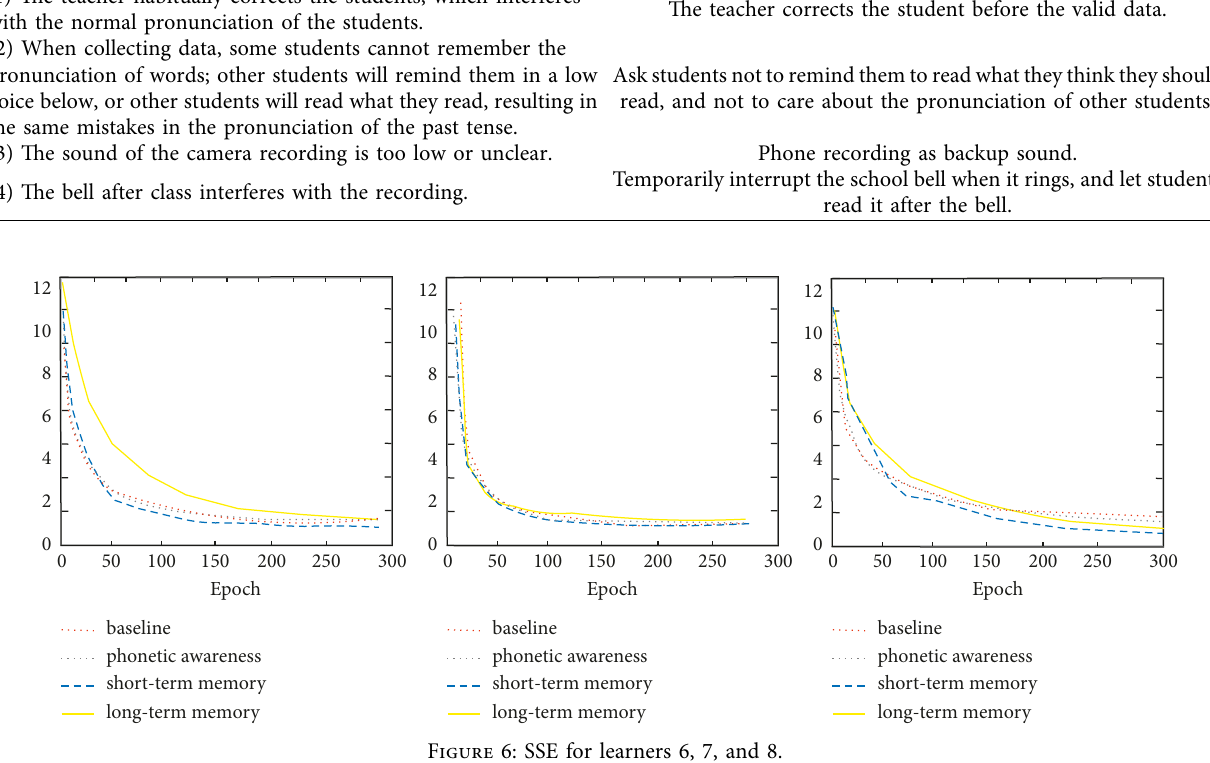
Table 3: The main problems encountered in the experimental process and the solutions adopted. Problems encountered during the experiment Solution taken